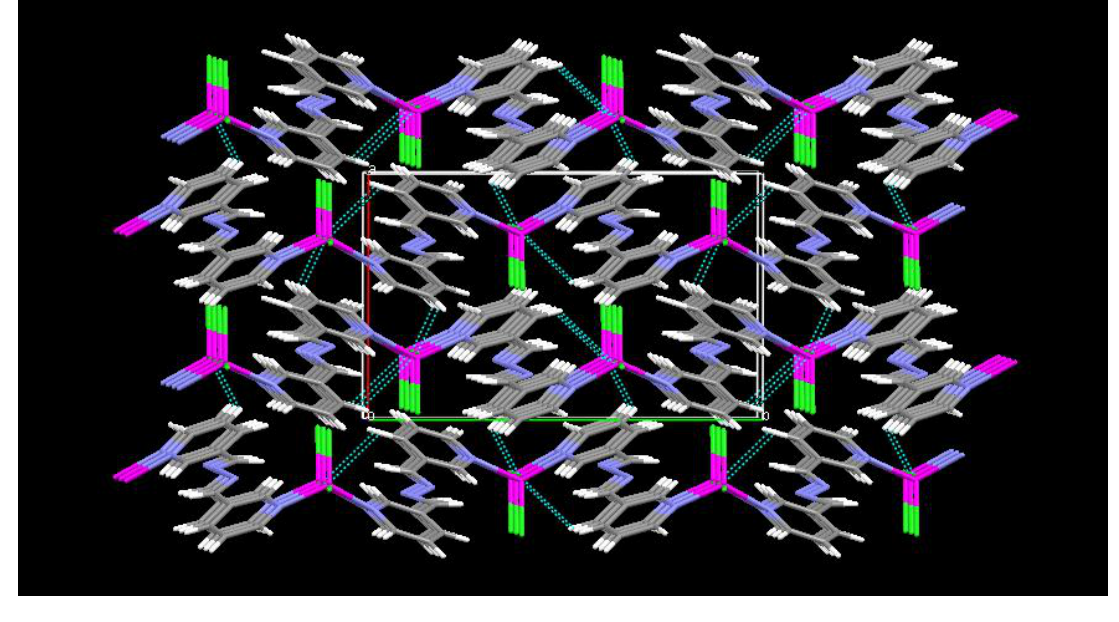
Figure 4. The packing diagram of compound 2 , viewed along the c axis. Dotted lines indicate hydrogen